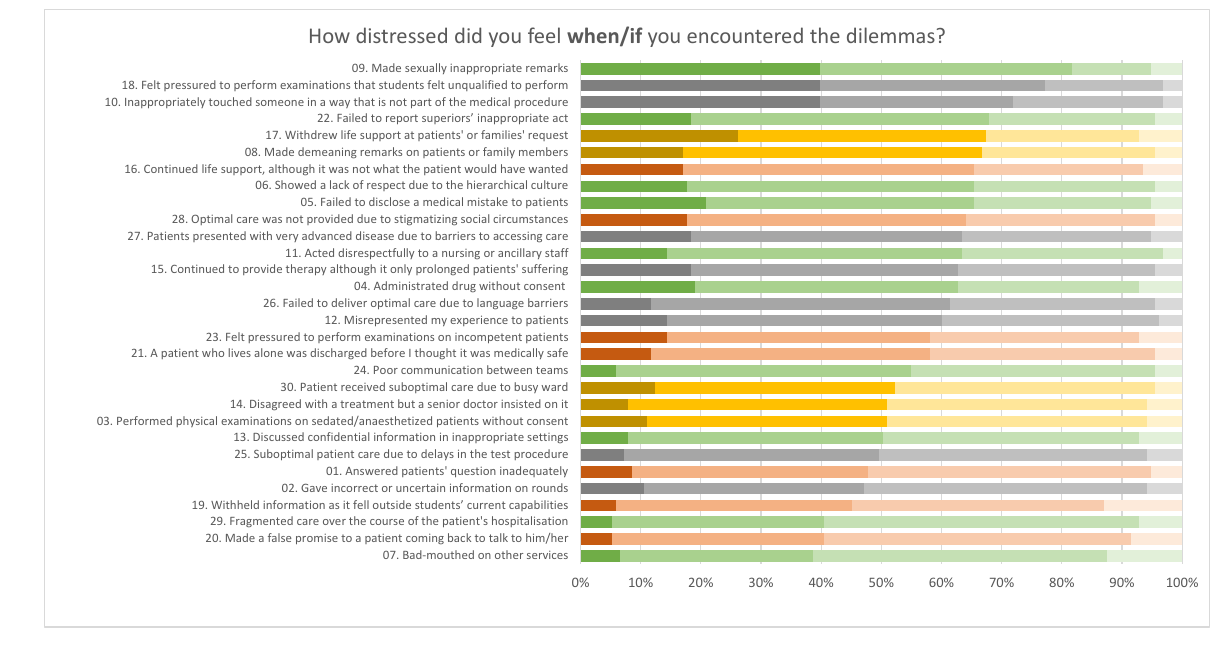
Figure 2. Perceived level of moral distress in the professionalism dilemmas. (1) Bar color indicates the theme of the measures: yellow = involvement in care perceived to be substandard; gray = professionalism lapses; green = responsibility exceeding students’ capabilities; orange = system constraints. (2) Dark and light color palette (from left to right): severe distress, moderate distress, mild distress, and no distress.